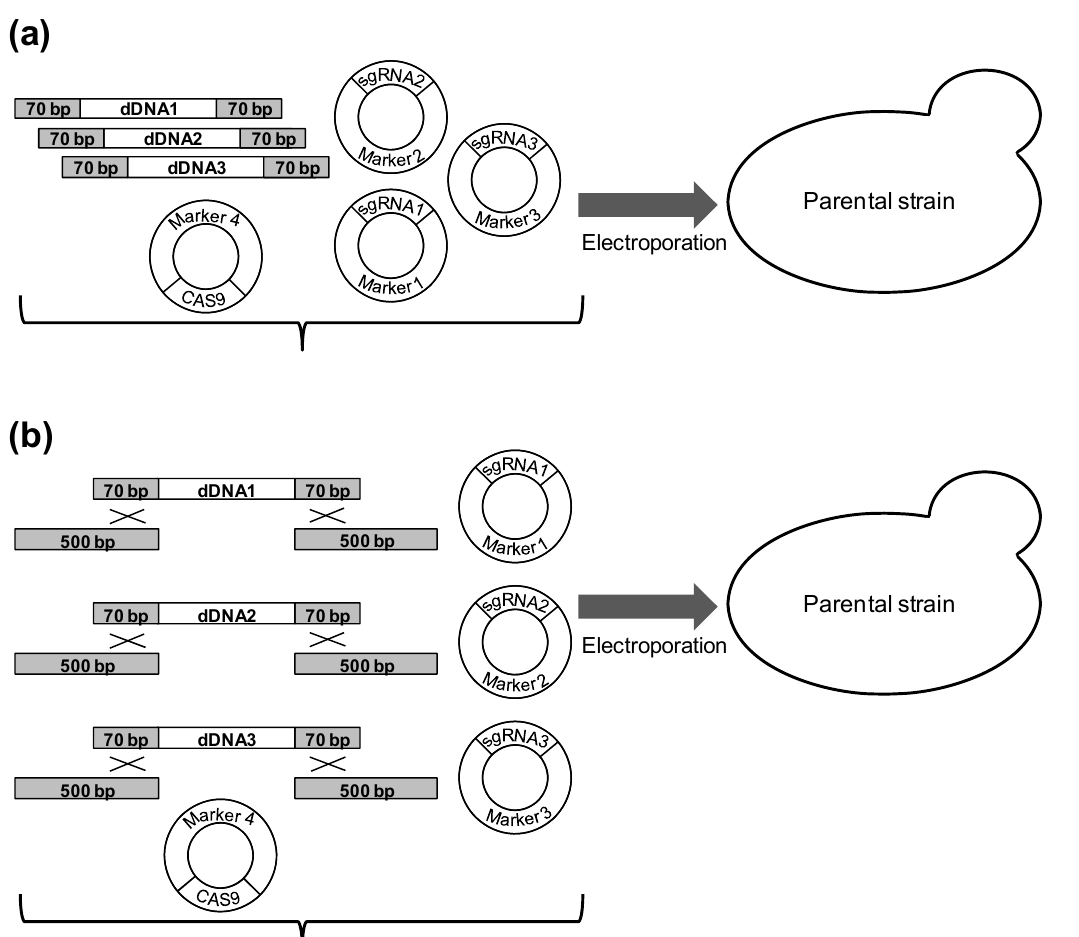
Figure 2. Proposed schemes for triple integration. ( a ) Transformation of the recipient strain with a plasmid expressing Cas9, three plasmids that each carrying one sgRNA expression cassette and an individual selective marker, and three dDNAs containing short (70 bp) flanks for recombination with the target locus. ( b ) The same as ( a ) but 0.5 kb arms for recombination with target loci that overlapped with integrated DNAs are added.